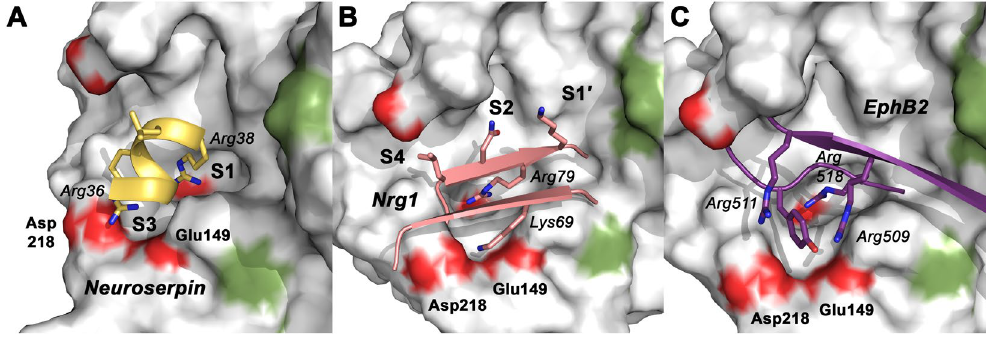
Figure 6. Models of natural protein substrates bound to the active site of KLK8. The molecular surface of KLK8 is shown with red patches of acidic residues and green for hydrophobic ones. ( A ) Human neuroserpin, a serine protease inhibitor from the hippocampus, is cleaved at Arg38 as P1 residue, which is located in the last turn of an α -helix, as observed in the crystal structure (PDB 3FGQ). Apparently, Arg36, Leu37 and Ala39 are suitable P3, P2 and P1 ′ residues in accordance with our profiling results. Proper binding and turnover by KLK8 requires a transition of the helical turn into a more linear, extended conformation. ( B ) The synaptic regulator neuregulin 1 (NRG1) possesses only P1-Arg79 and P2-Asn78 as KLK8 specific substrate residues at its cleavage site. According to a structure-based homology model, created by SWISS-MODEL 79 they belong to a β -strand, while the Leu77 side-chain might occupy the S4 instead of the S3 subsite. However, an adjacent β -strand contains Lys69, which is located close to Glu149 and Asp218, substitute the preferred basic P3 side-chain. ( C ) Similarly, a model from SWISS-MODEL of the neuronal KLK8 substrate ephrin type-B receptor 2 (EphB2), exhibits an arrangement of two strands, with P1-Arg518 as only specific residue for cleavage by KLK8. Interestingly, Arg509 and Arg511 might be ideally positioned for electrostatic interaction with Glu149 and